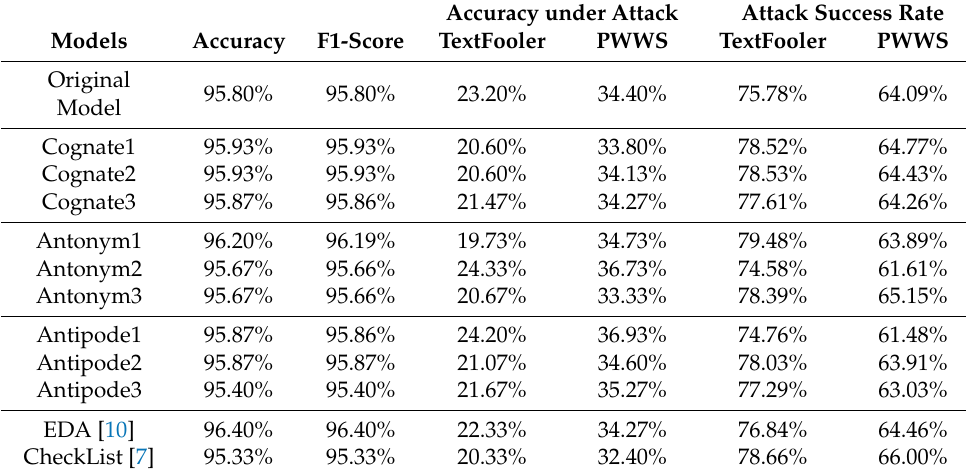
Table A3. SUBJ Performance and Robustness Results.